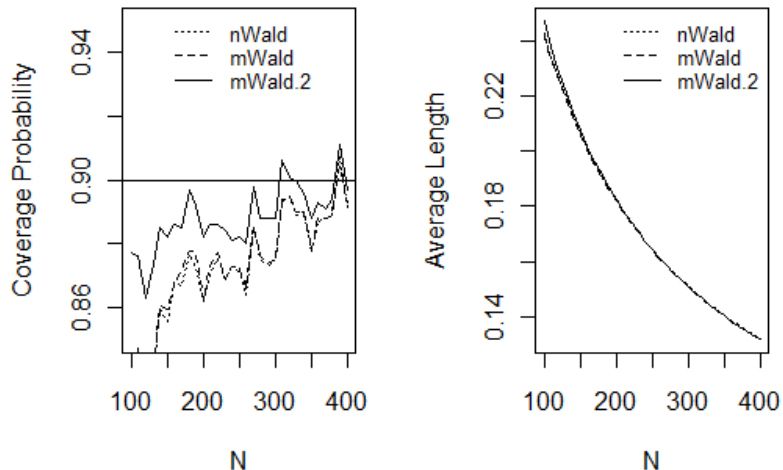
Figure 2. Coverage probabilities and average lengths versus total sample sizes N where ( p 1 , p 2 ) = (0.1, 0.2). The false positive rate is ϕ = 0.1 and the ratio of substudy sample size versus the total sample size s = n / N = 0.2.